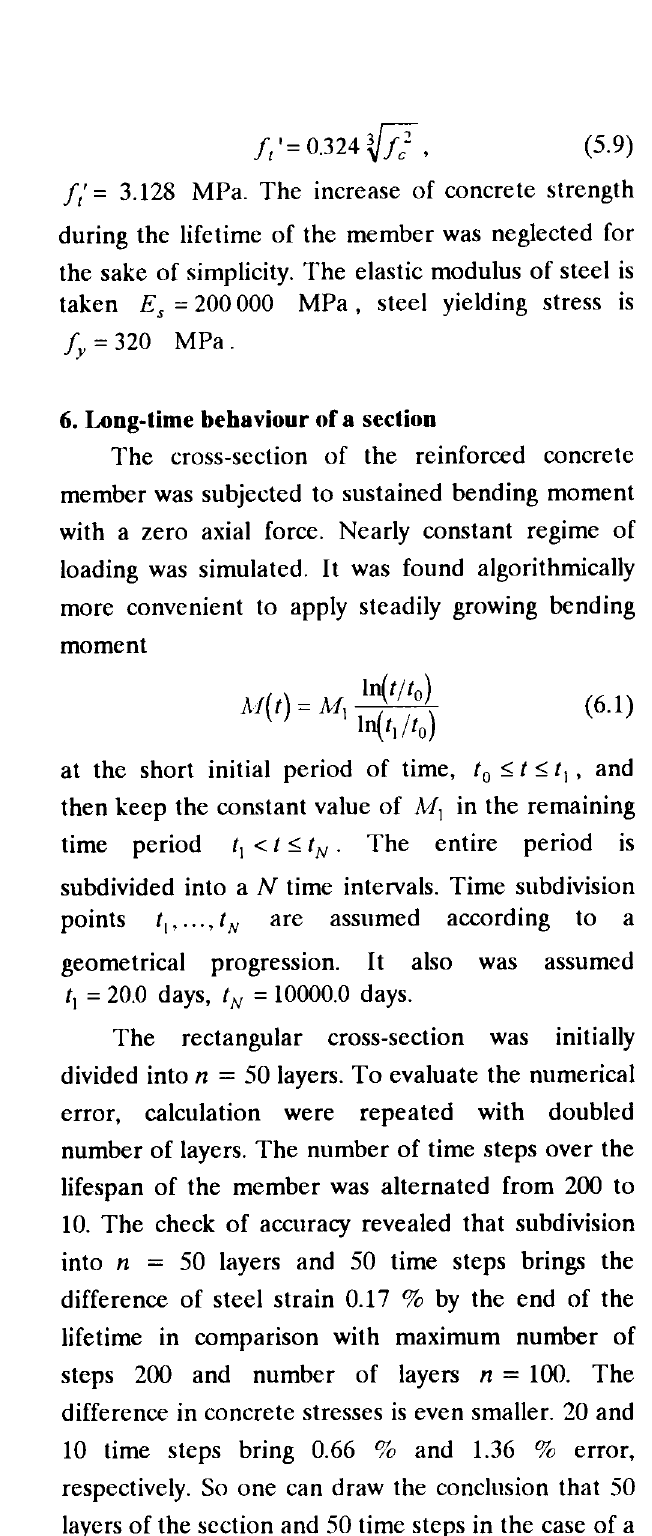
Fig 6. Stress distribution over the cross-section at the time momenl'i 11 = 20 and fN= 10000 days